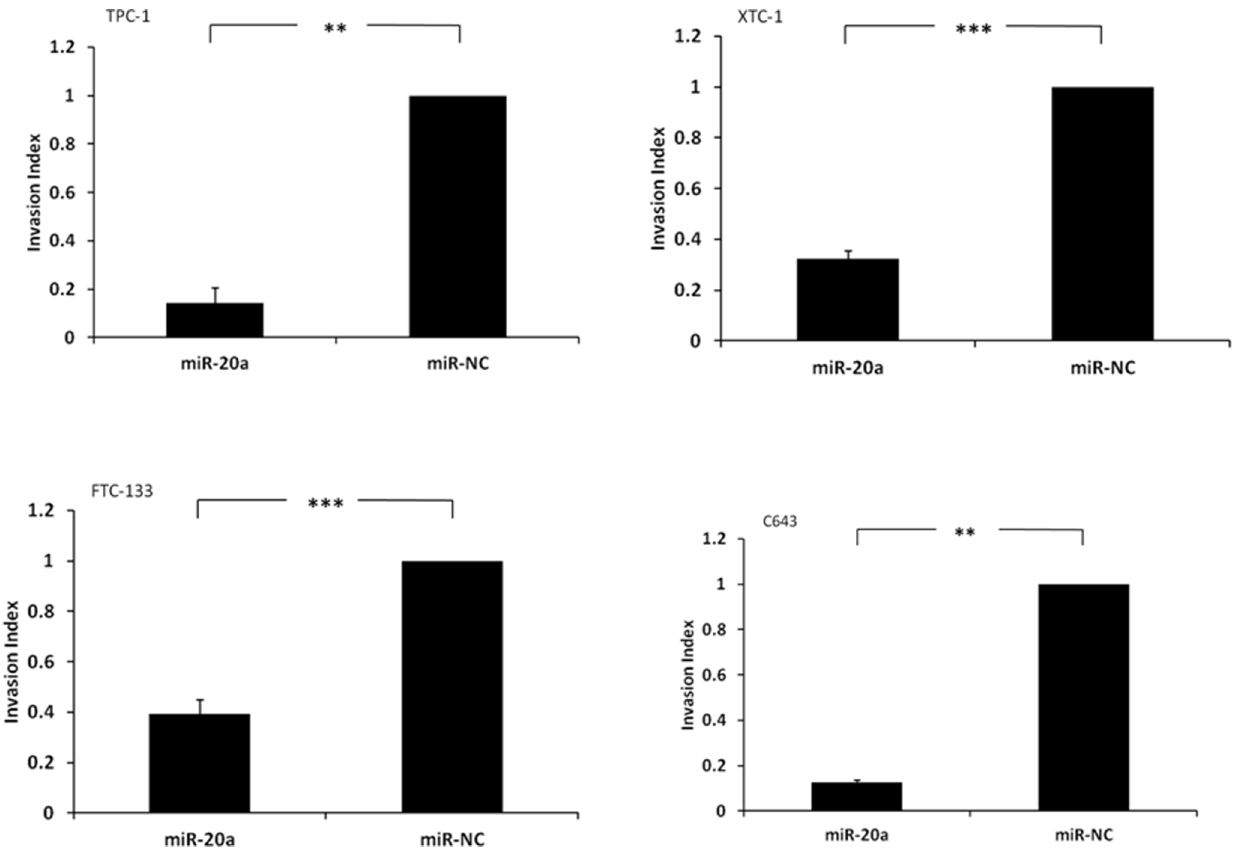
Figure 4. MiR-20a overexpression inhibits thyroid cancer cell invasion. ( A ) TPC-1 thyroid cancer cell line, ( B ) XTC-1 thyroid cancer cell line, ( C ) FTC-133 thyroid cancer cell line, and ( D ) C643 thyroid cancer cell line. The Y axis represents the invasion index of the thyroid cancer cells. Error bars represent standard error of mean (* indicates p , 0.05; ** indicates p , 0.01; *** indicates p , 0.001).